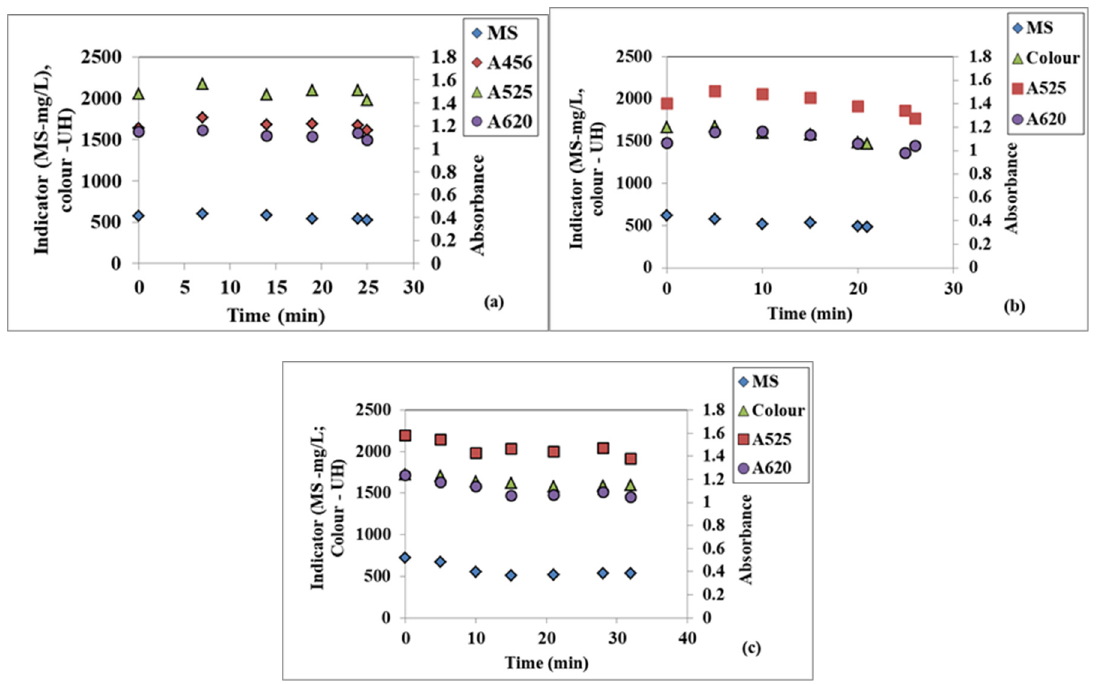
Figure 3. Variation in the time of the textile WW suspended solids (MS) and colour at a 30 L/h flowrate and three different rotational speeds: ( a ) 100 rpm, ( b ) 300 rpm, ( c ) 500 rpm.